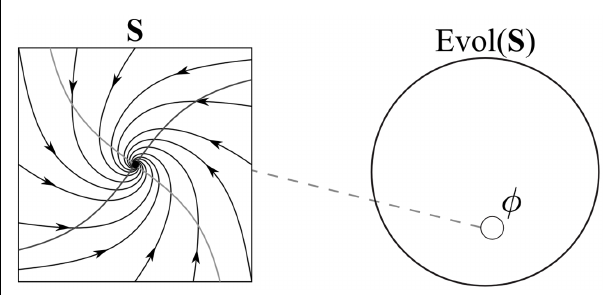
FIGURE 1 |A phase portrait φ on S corresponds to a subset of Evol(S). The relative size of φ and Evol( S ) are for illustrative purposes only (similarly for subsequent